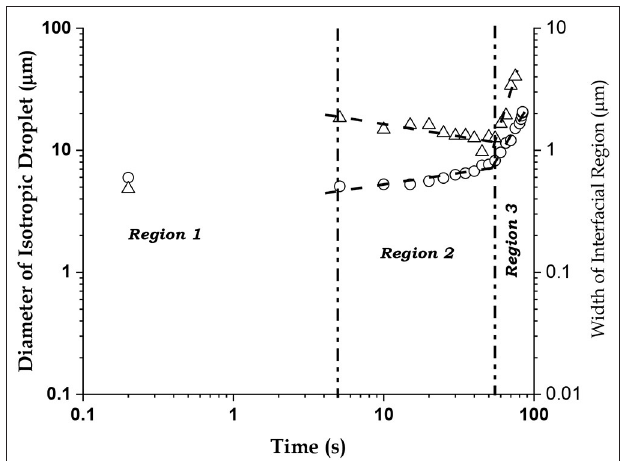
FIGURE 3 | The Quasistationary State (QSS). Log-log plots of the diameter ( D , in µ m, open circles) of the isotropic phase (dark droplet at the center of the laser beam) and the width ( w , in µ m, open triangles) of the interfacial region containing nematic clusters, vs. time (in s). The QSS occurs in Region 2.